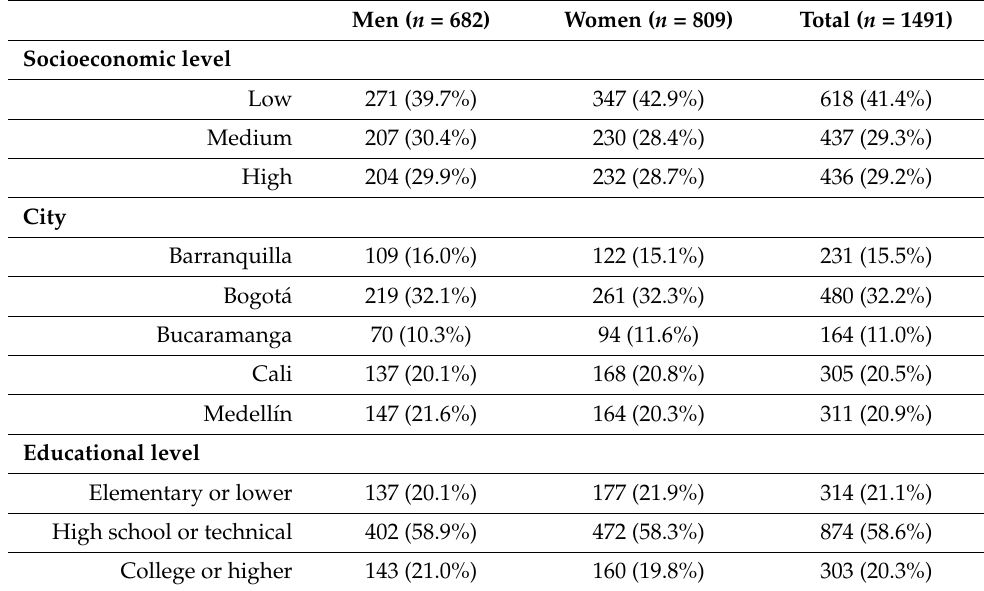
The mean daily consumption of calories from sugary drinks was significantly higher among men than women (334 vs. 287 Cal/d on average, p = 0.017) and decreased steadily across age groups in both sexes ( p < 0.001) (Figure 1). Consumption was also considerably lower in the high SEL compared to low ( p = 0.002), especially for women. The intake of calories from sugary drinks decreased with higher education ( p = 0.034) but in this case more pronouncedly in the male sex. Both men and women with excess body weight reported less calories from sugary drinks ( p = 0.007 for overweight vs. low/normal, p = 0.024 for obesity vs. low/normal).